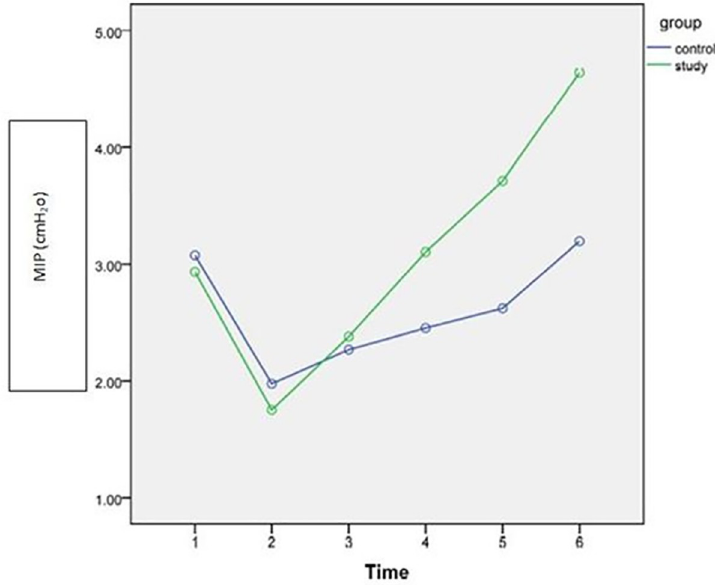
Fig 5. Estimated marginal means of MIP [1: Pre-operative; 2: POD3; 3: Discharge; 4: 4 th POW; 5: 8 th POW; 6: Follow-up].